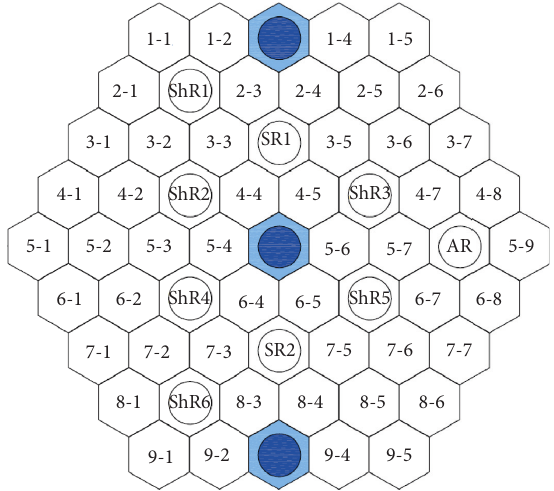
Figure 3: The MPRR core map with the hexagonal cell coordinates. SR: safety rod; ShR: shim rod; AR: automatic regulating